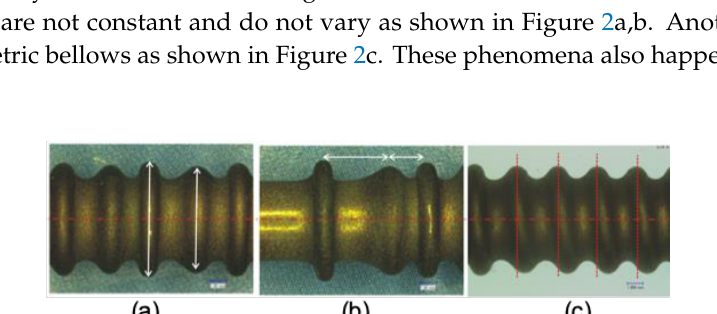
Figure 1. Schematic of the semi-dieless bellows forming with a local heating technique.